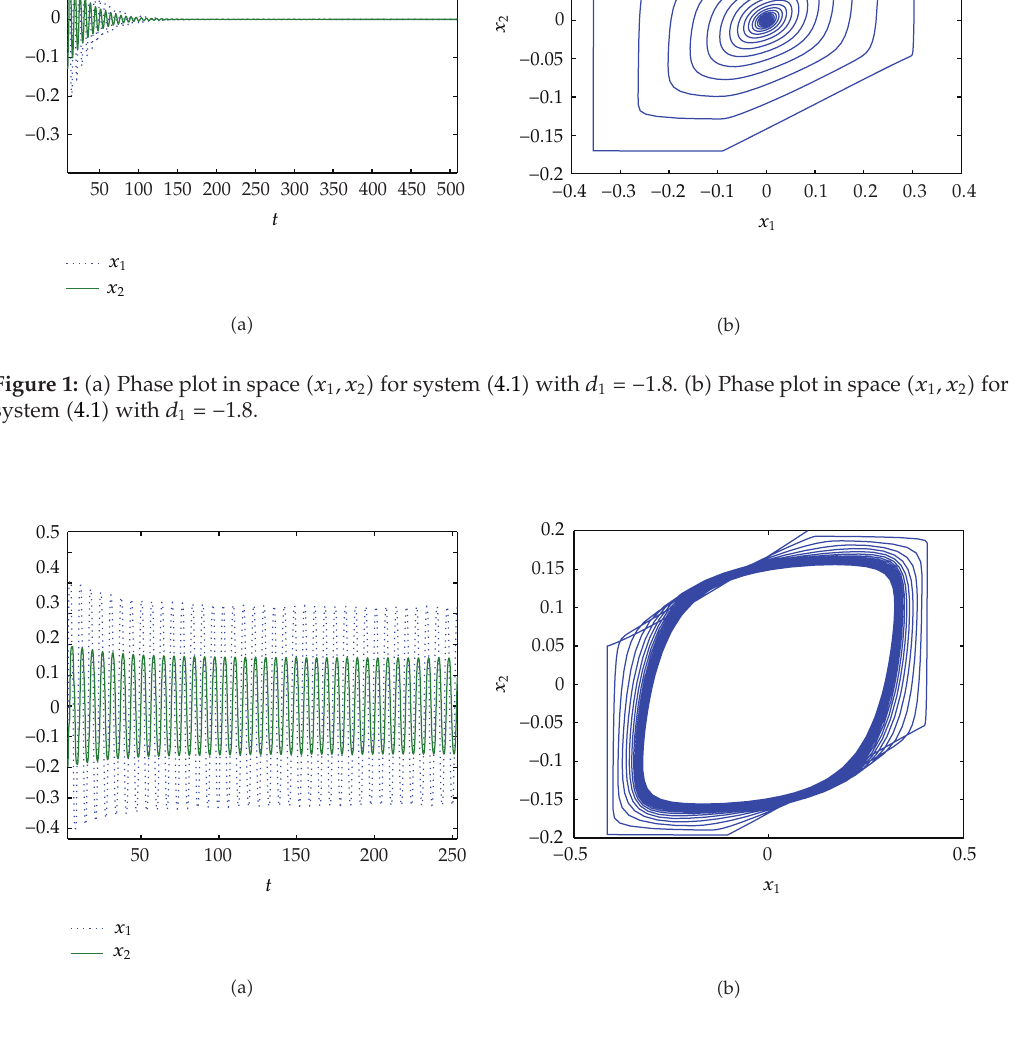
Figure 2: (cid:6) a (cid:7) Phase plot in space (cid:6) x 1 ,x 2 (cid:7) for system (cid:6) 4.1 (cid:7) with d 1 (cid:8) − 2 . 1. (cid:6) b (cid:7) Phase plot in space (cid:6) x 1 ,x 2 (cid:7) for system (cid:6) 4.1 (cid:7) with d 1 (cid:8) − 2 .